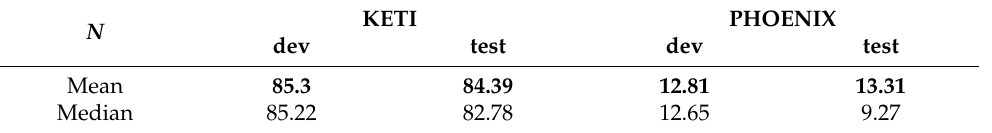
Table 6. BLEU-4 score by N